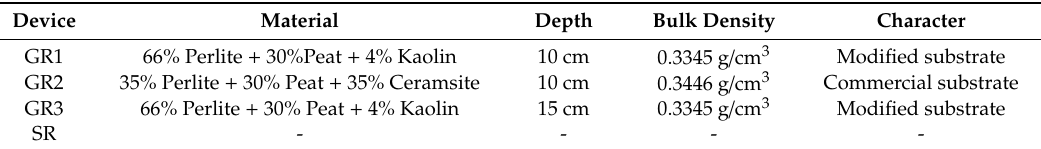
Table 1. Substrate structure of experimental devices.